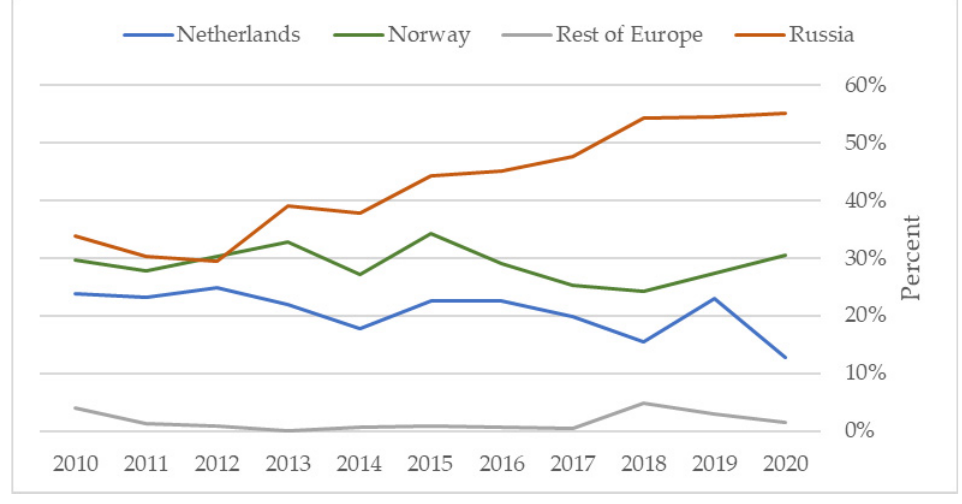
Figure 2. Origin of German natural gas imports: 2010–2020. Source: [2].